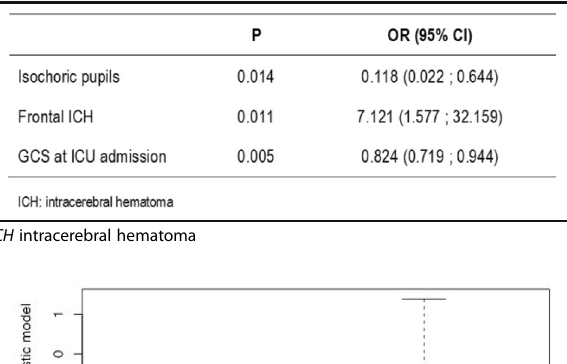
Table 2 (abstract 001123). Multivariate logistic regression for death